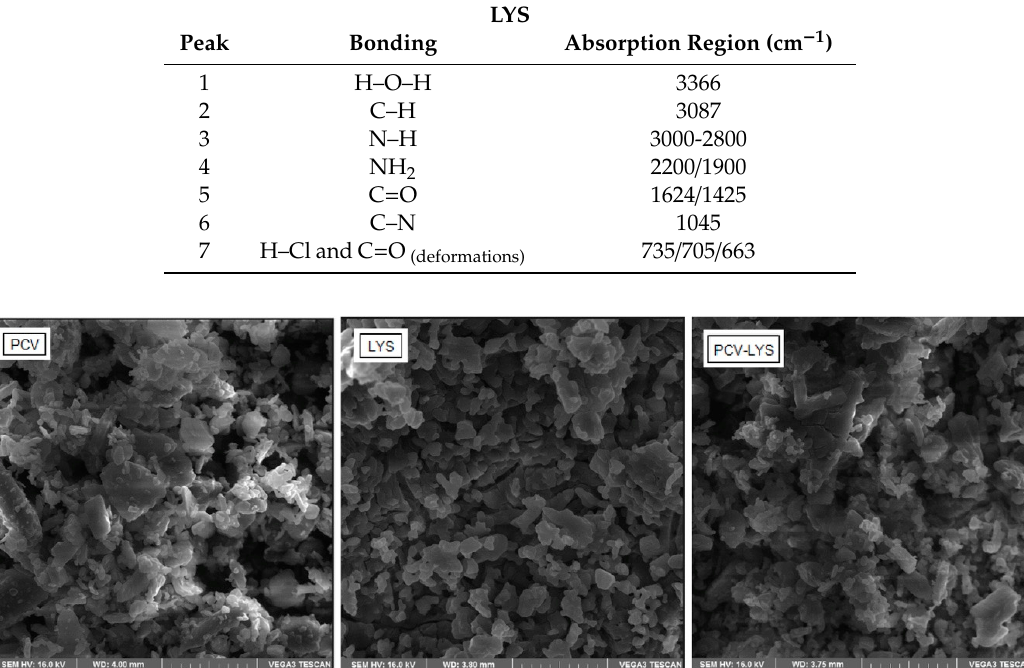
Figure 5. Photomicrographs of PCV, LYS, and PCV-LYS using scanning electron microscopy (SEM) (2880×).